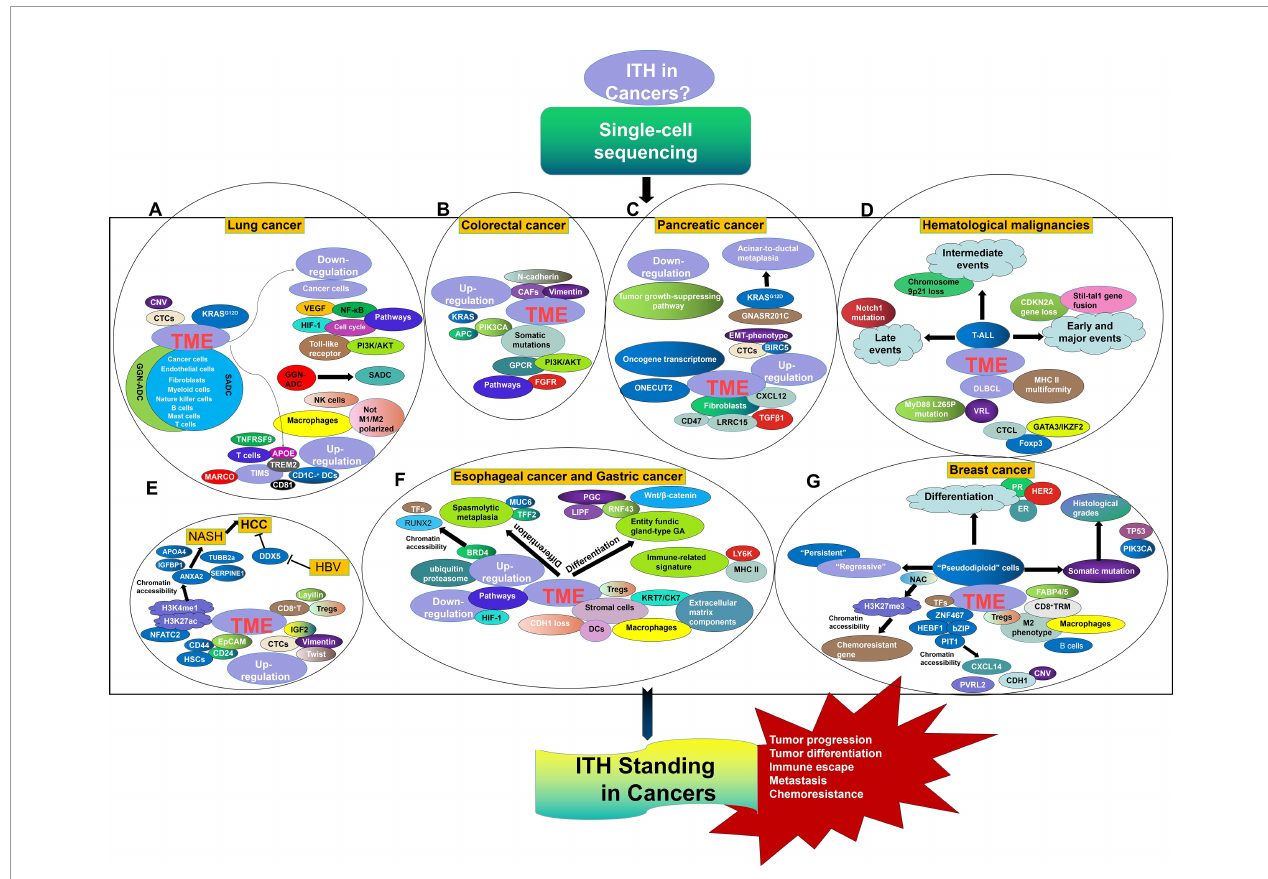
FIGURE 1 | ITH Standing in Lung cancer (A) , Colorectal cancer (B) , Pancreatic cancer (C) , Hematological malignancies (D) , HCC (E) , Esophageal cancer and gastric cancer (F) , and Breast cancer (G) from the perspective of